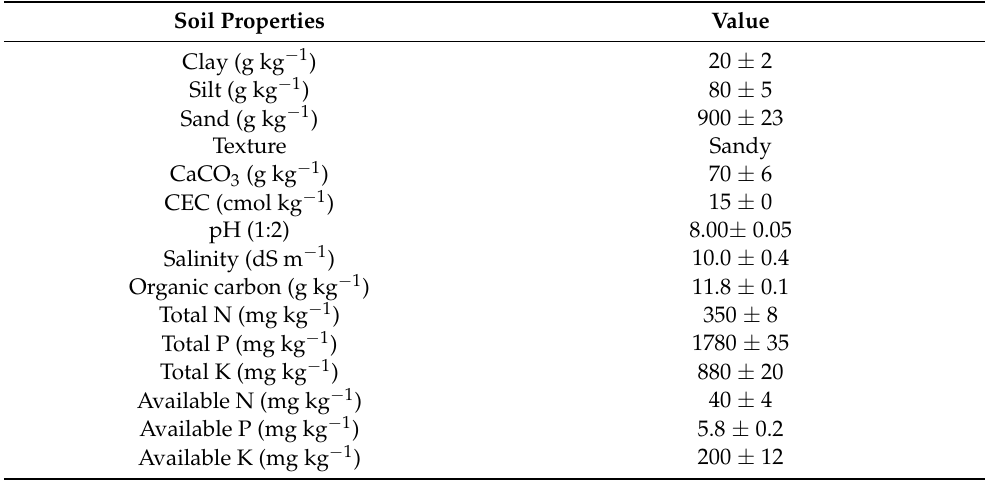
Table 2. Basic soil